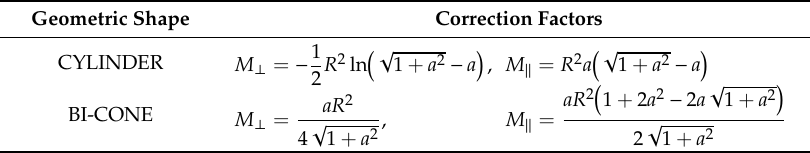
Table 2. Correction factors dependence on the geometric shape of nanoparticles. Geometric